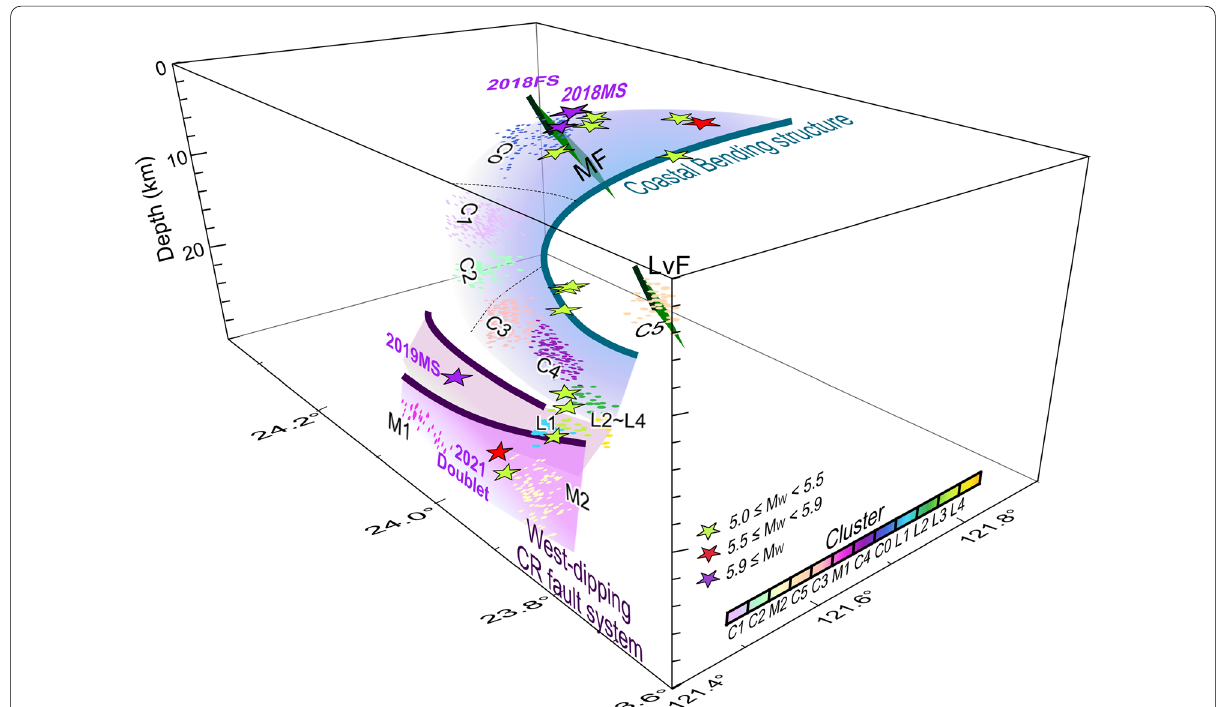
Fig. 9 3D sketch of proposed seismogenic structures combining BP imaging, empirical ruptures, and PCA results, where stars and circles denote larger earthquakes and cluster events,